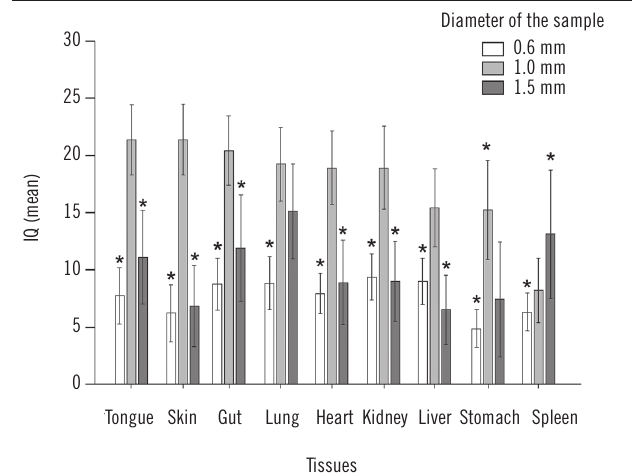
figurE 3 − Influence of the combination of the type of tissue and the diameter of cylinders in the IQ of samples inserted in the recipient blocks, considering the size of gaps between them The values of quality were represented as mean ± confidence interval (95%). Each combination of tissue and diameter was compared with the value from the best sample (tongue – 1.0 mm). The results were analyzed by the Kruskal-Wallis and Dunn statistical tests. The p -value were adjusted using the false discovery rate proposed by Benjamini- Hochberg and the (*) p -value < 0.05 was considered significant. IQ: index of